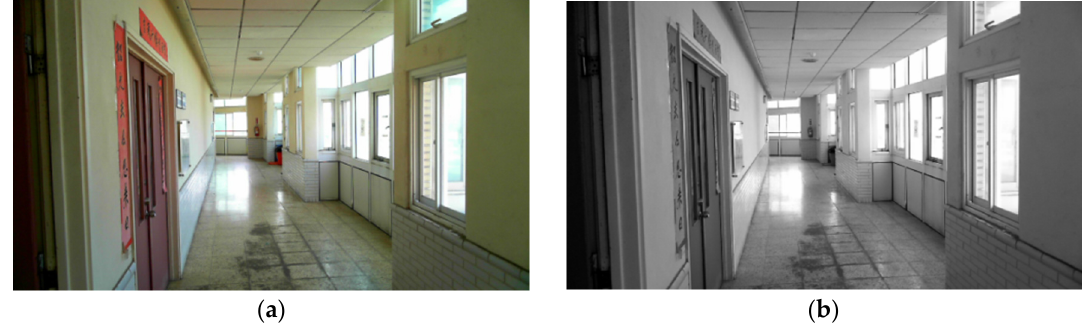
Figure 1. ( a ) RGB image and ( b ) hue, saturation, and lightness (HSL) image.